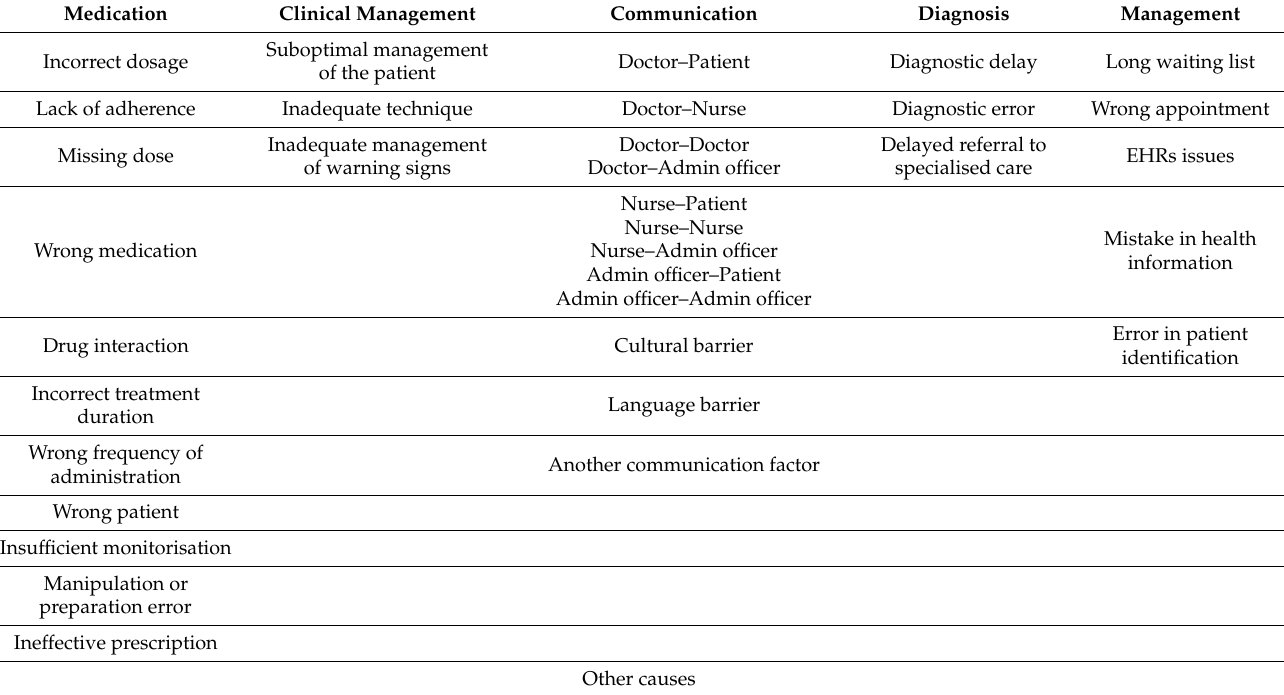
Table 1. Causal factors according to APEAS study